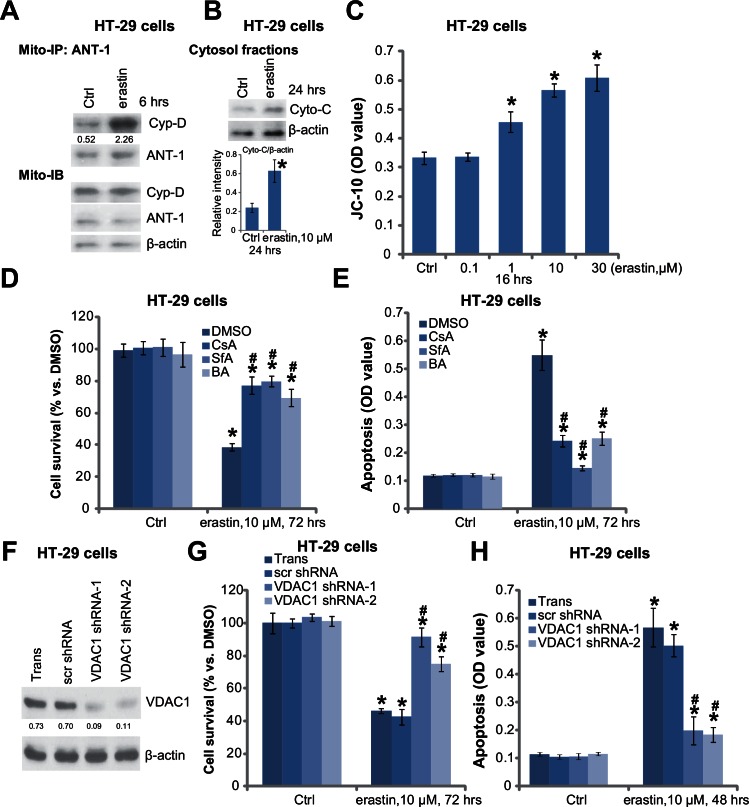
Erastin induces mPTP opening in cultured colorectal cancer cells.HT-29 cells were treated with applied erastin for indicated time, mPTP opening was evidenced by mitochondrial VDAC-1-ANT-1 association (A), cytochrome C (“Cyto-C”) release (B) and JC-10 intensity increase (C). HT-29 cells were pre-treated with sanglifehrin A (SfA, 2.5 μM), cyclosporin A (CsA, 0.5 μM) or bongkrekic acid (BA, 5 μM) prior to erastin (10 μM) treatment, cell survival (D) and apoptosis (E) were analyzed afterwards. Stably HT-29 cells expressing VDAC-1 shRNA-1/-2 or scramble control shRNA (“scr shRNA”) were treated with erastin (10 μM), VDAC-1 expression (F), cell survival (G) and apoptosis (H) were tested. ANT-1-assocaited Cyp-D (A), cytosol cytochrome C expression (B) and VDAC-1 expression (F) were quantified. For each assay, n = 4. The data presented were mean ± SD. Experiments were repeated three times with similar results obtained. * p < 0.05 vs. group of “Ctrl”. # p < 0.05 vs. group of erastin only (D and E) or the “scr shRNA” group (G and H). “Trans” stands for transfection control (F-H).